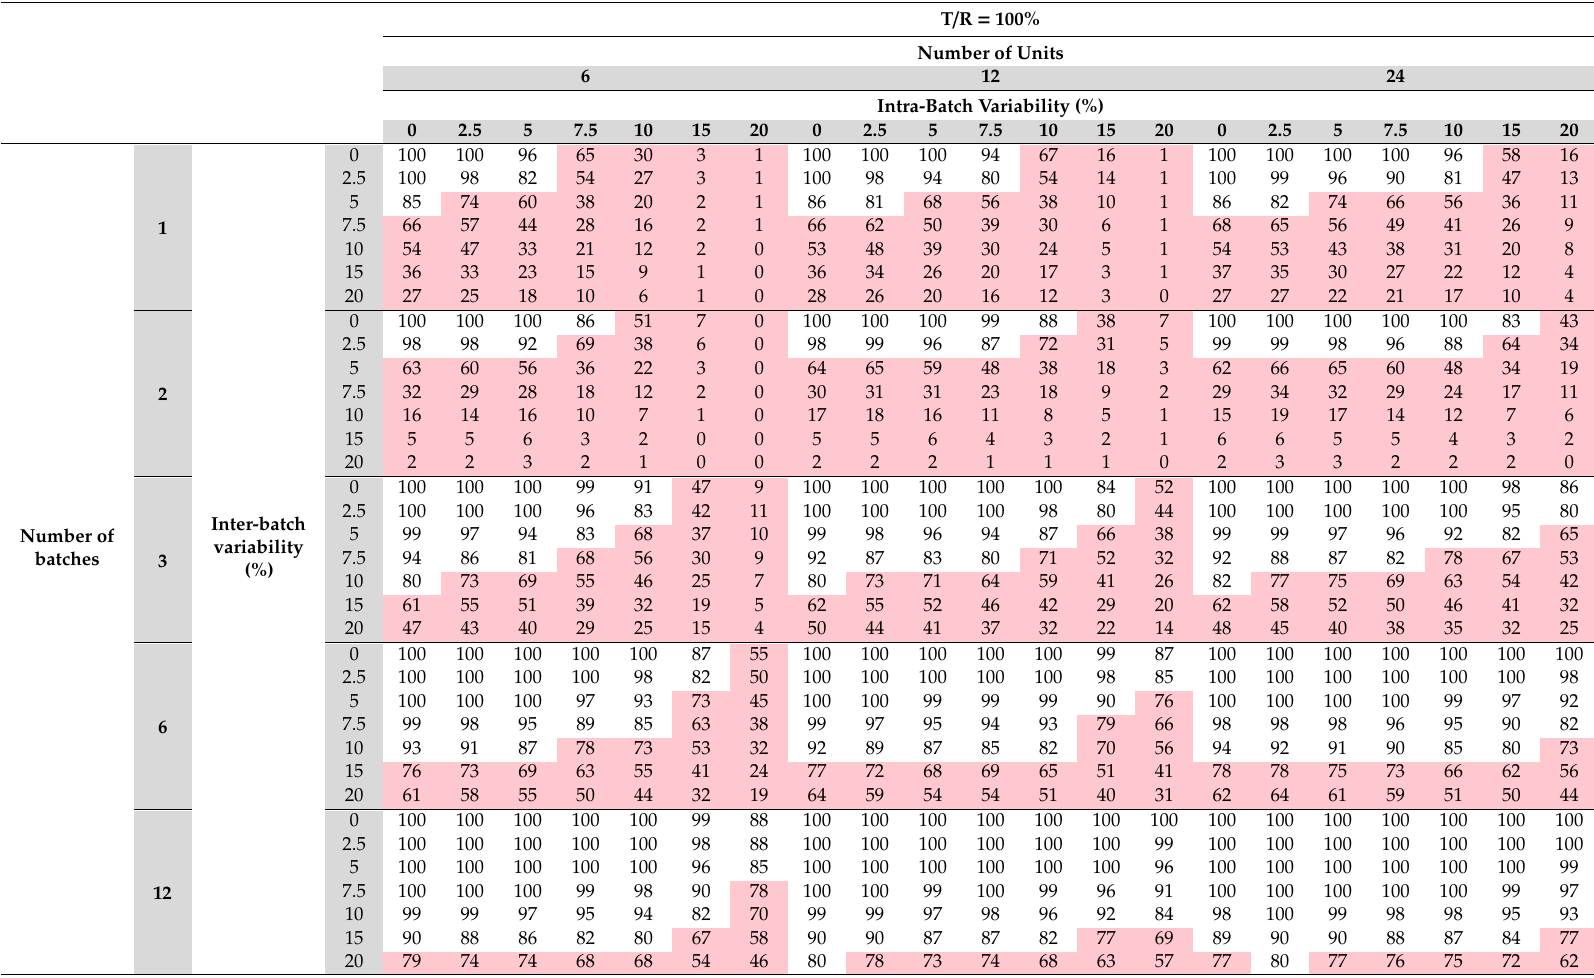
Table 1. Probability of similarity when the population di ff erence between reference and test products is 0 (T / R = 100%). Number of batches and inter-batch variability are depicted in the left margin and number of replicates and intra-batch variability at the top of the table. In red are outlined the scenarios with a probability lower than